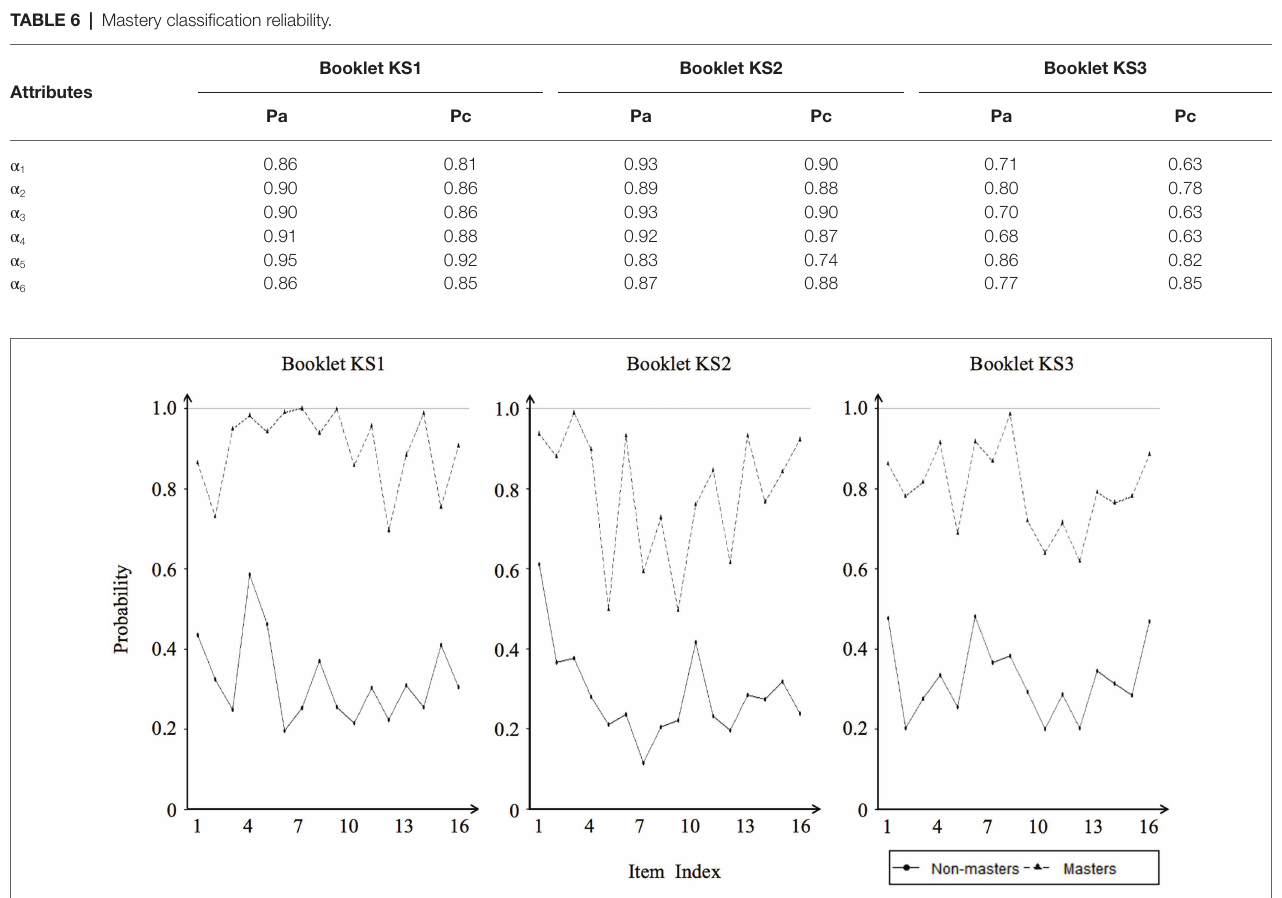
FIGURE 2 | Item mastery plots.